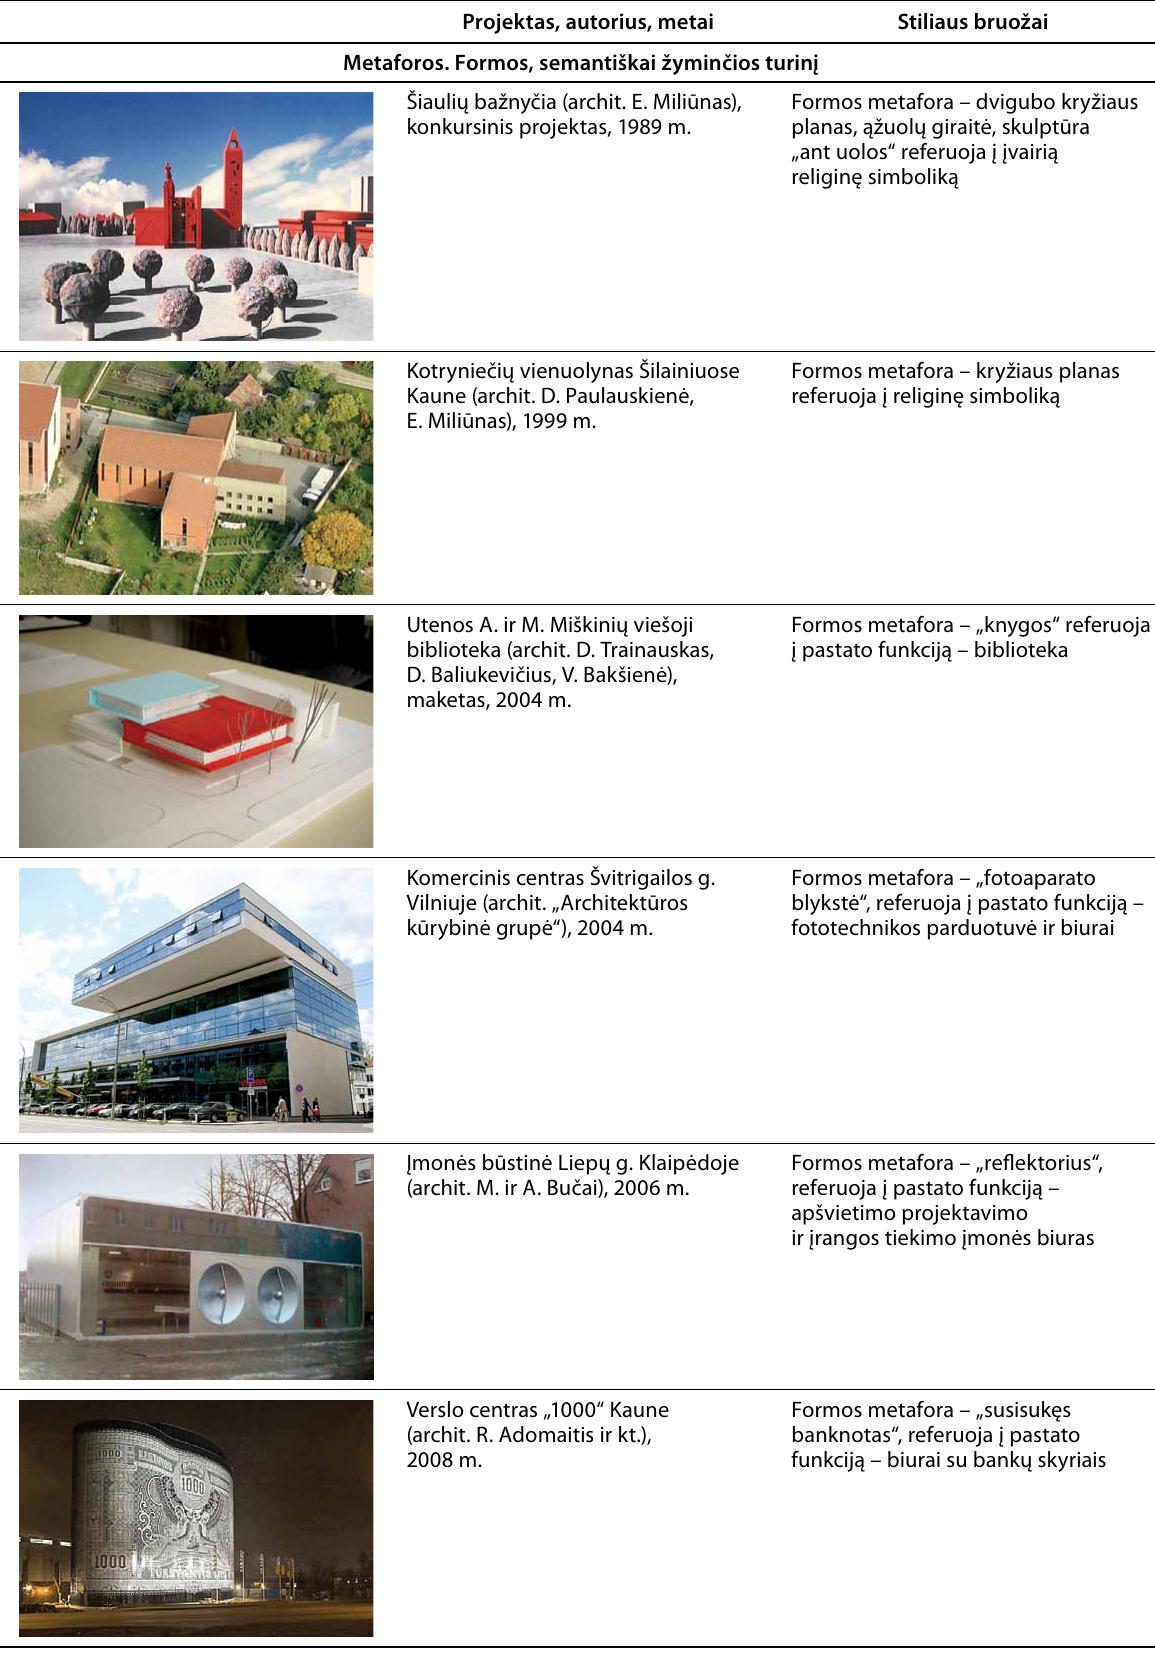
Table 1. architectural examples of metaphorical forms in